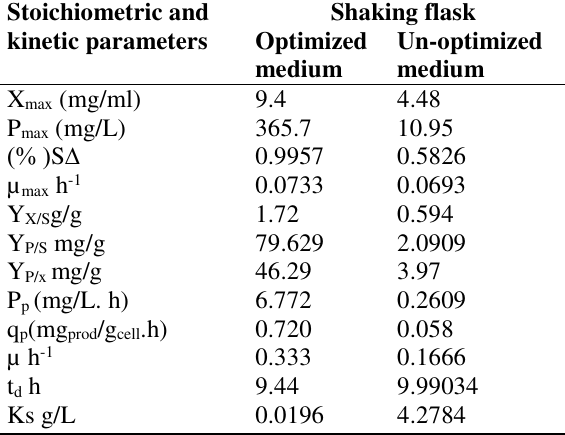
Stoichiometric and kinetic parameters associated with prodigiosin and S. calculated from experimental result of shaking flask.